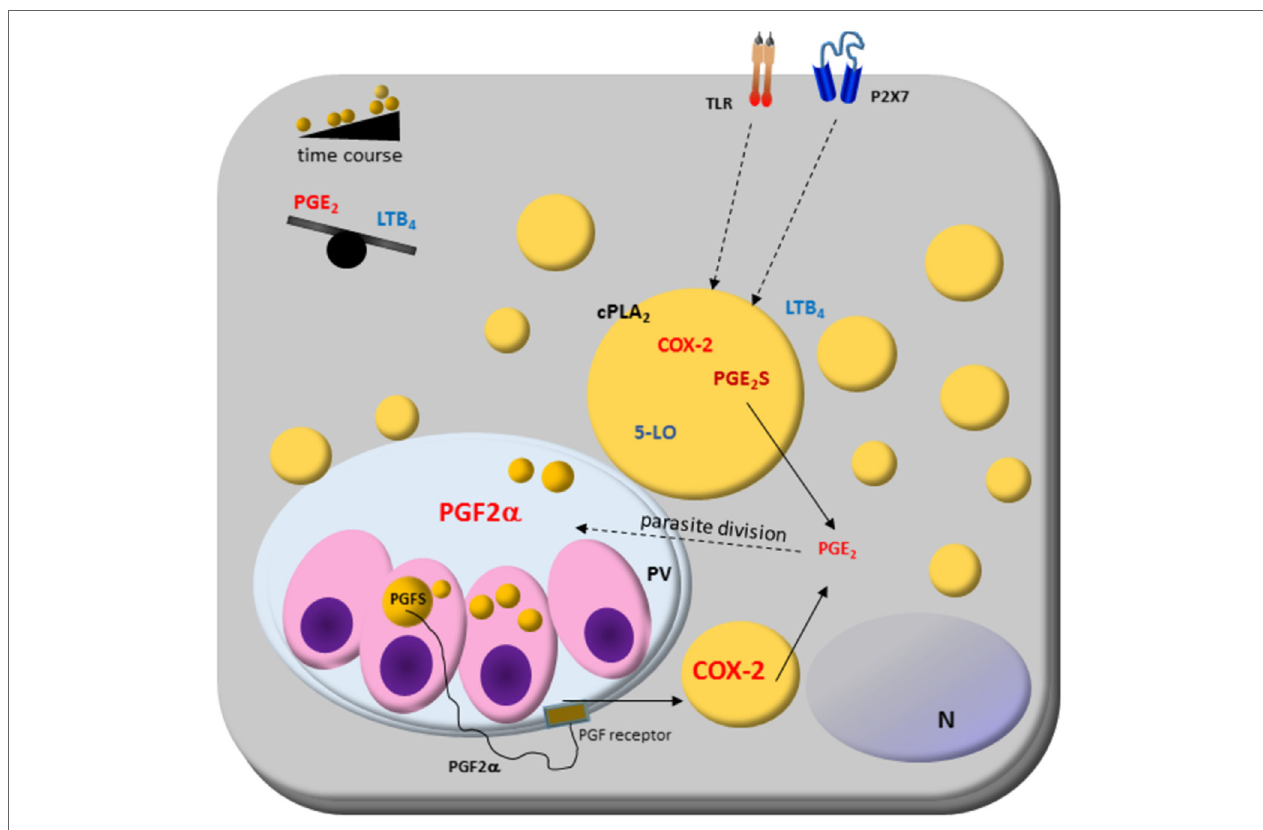
FiGURe 2 | Host cell lipid droplet (LD) biogenesis in response to interaction with protozoan parasites. Increased numbers of LDs occur in the cytoplasm of many cell types after infection with different parasite-containing vesicles as well as on cytoplasm of these parasites, such as Trypanosoma spp., Leishmania spp., Plasmodium spp., and Toxoplasma gondii . The signaling from toll-like receptors (TLRs) by pathogens and pathogen-derived molecules triggers signaling pathways, such as PPARs and MAPKs, which are involved in the formation of LD. LDs produce lipid mediators; they compartmentalize both the substrate and the enzymatic machinery necessary for eicosanoid syntheses, such as cPLA2, cyclooxygenases (COX)-2, and prostaglandin synthases. Prostaglandin E 2 (PGE 2 ) production benefits parasite survival, as shown in Trypanosoma , Leishmania , Plasmodium, and Toxoplasma infections . On the other hand, leukotriene B 4 (LTB 4 ) production by host cells via P2 × 7 receptor is related to parasite killing as seen in Leishmania infection, where LDs biogenesis and an anti-inflammatory balance in the PGE 2 /LTB 4 axis could facilitate the Leishmania transmissibility and infection in vivo. Cytoplasmic LD in Leishmania express prostaglandin F2 α synthase (PGFS) responsible for PGF 2 α production. The PGF 2 α receptor (FP) is present on parasite vacuole (PV) surface, suggesting these LDs could act as a virulence factor. Then, LD could be involved in inflammation and immune